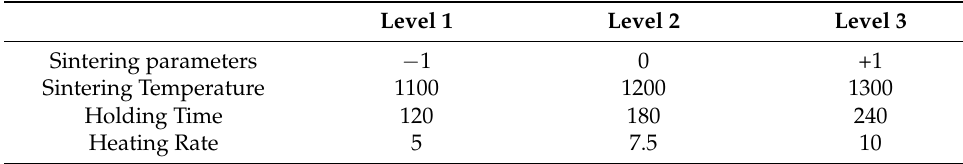
Table 1. Sintering parameter and their